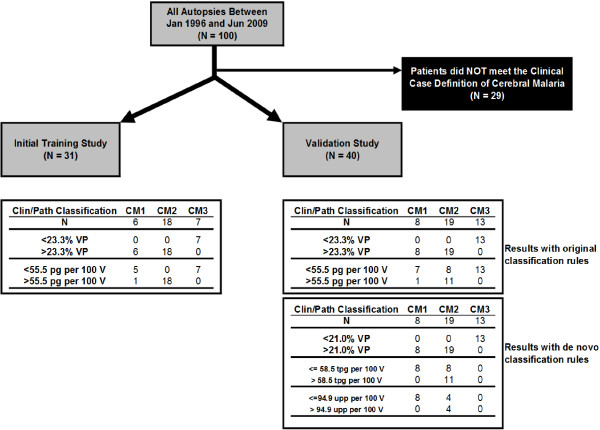
Study flow chart and classification results from CART analysis. The initial training and testing study (on left) represents the original data from [15]. The validation study, using 40 new cases, is shown on the right with the original classifications rules applied (upper results table) and a de novo set of classifications rules (based on the 40 new cases, lower results table). The first node (separating patients with any cerebral sequestration from patients without evidence of cerebral sequestration) remained stable (23.3% vs 21%) with no classification errors. The second node (separating patients with sequestration only from patients with sequestration and extravascular pathology including ring haemorrhages) also remained stable (58.5 pg/100 vessels vs 55.5 pg/100 vessels). A third node was required (<= or >94.9 UPP/100 vessels) to separate the remainder of these latter two categories; however there were, in total, four classification errors using this new model.